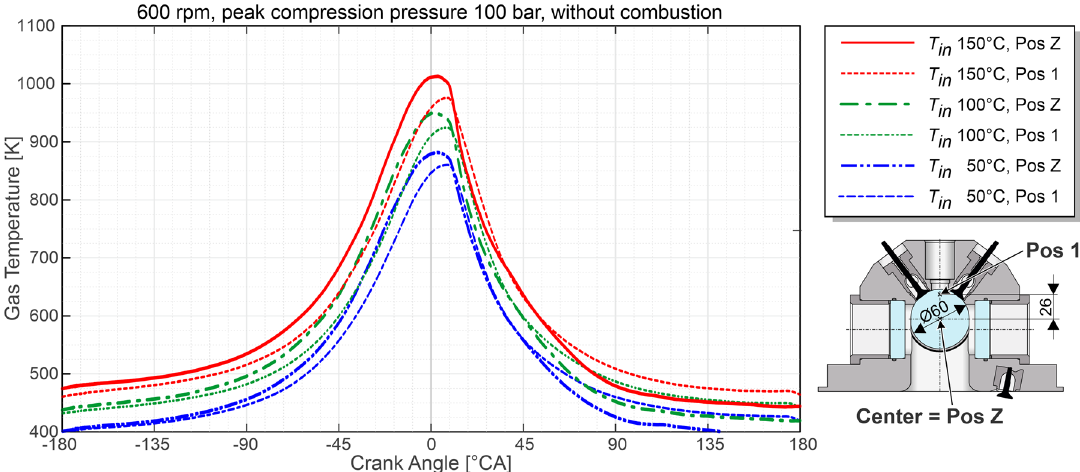
Figure 12. Measurement of the gas temperature (with a single Ø12.5 µ m TC) at two locations inside the combustion chamber. The variation of the preheated intake air temperature T in results in a density variation, since the peak compression pressure was kept at 100 bar for all cases.